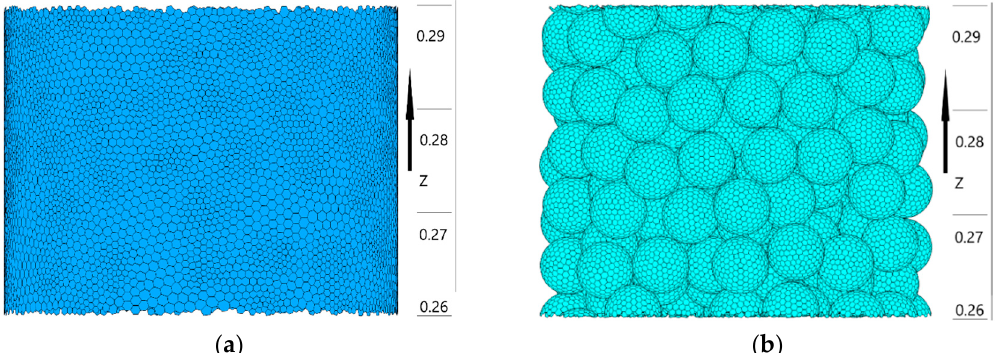
Figure 2. Cell distributions in the burner wall and pellet walls. ( a ) Cell distributions in burner wall. ( b ) Cell distributions in pellet walls. Table 1. Properties of Al 2 O 3 pellets [19,22].